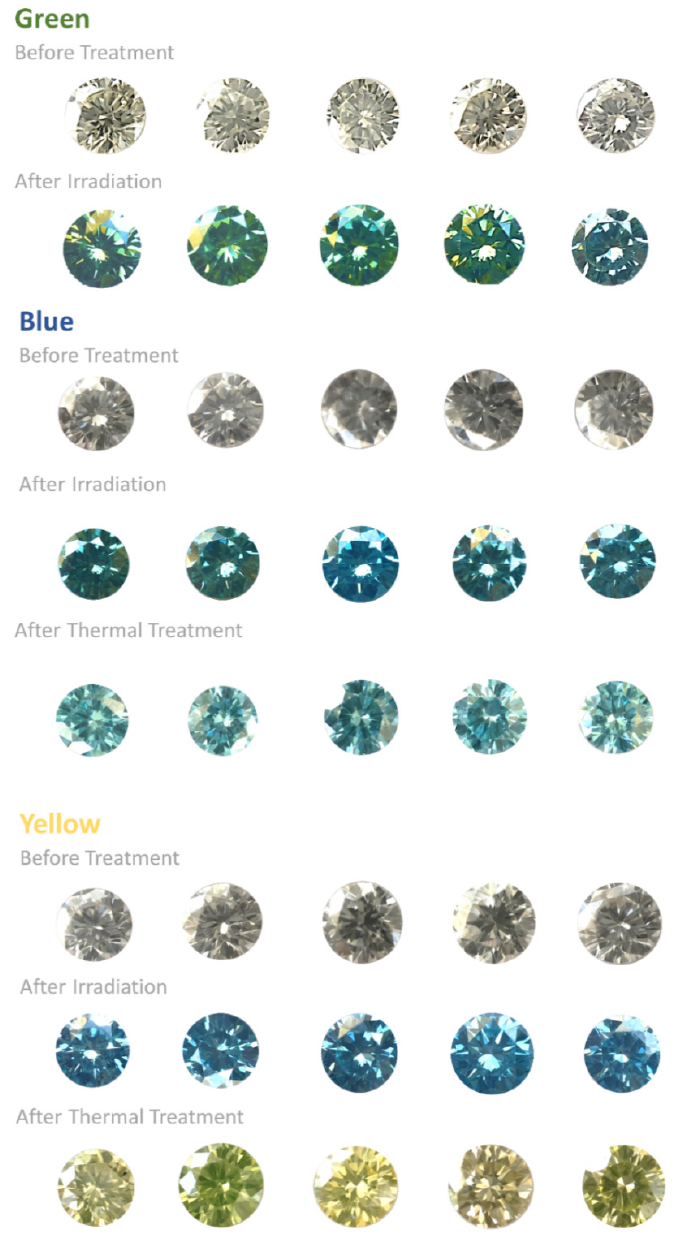
Figure 3. Daylight photographs of the green, blue and yellow diamonds: pre- and post-irradiation and, for the blue and yellow diamonds, post-thermal treatment. Green: from clear crystal to green-yellowish/green-turquoise (irradiation); blue: from clear to dark-greenish (irradiation) to blue (annealing); yellow: from clear to blue (irradiation) to yellow (annealing). The irradiation process that was carried out for the diamonds is as follows. The final diamond colors produced were green, blue, and yellow, diverging in their Production of treated GREEN diamonds: The first stage was 1.5 h of irradiation in shade/tint/opaqueness; this is of great importance in the diamond trade market. Among the LINAC with an electron energy range of 0.8–2 MeV. No further treatment was needed. the three colors, blue is the most popular, followed by yellow and finally green in the The irradiated diamonds had varying green colors: two diamonds had a green-yellowish jewelry trade. In general, lighter and softer colors are more profitable to produce because tint, two diamonds were deep green, and one was green-turquoise. There was no need for they sell better; however, when a vivid color appears, it will also sell well. Therefore, the further thermal treatment to obtain a green color. results of this study provide a comprehensive understanding of what occurs throughout various treatments and their significance in producing the final shade or